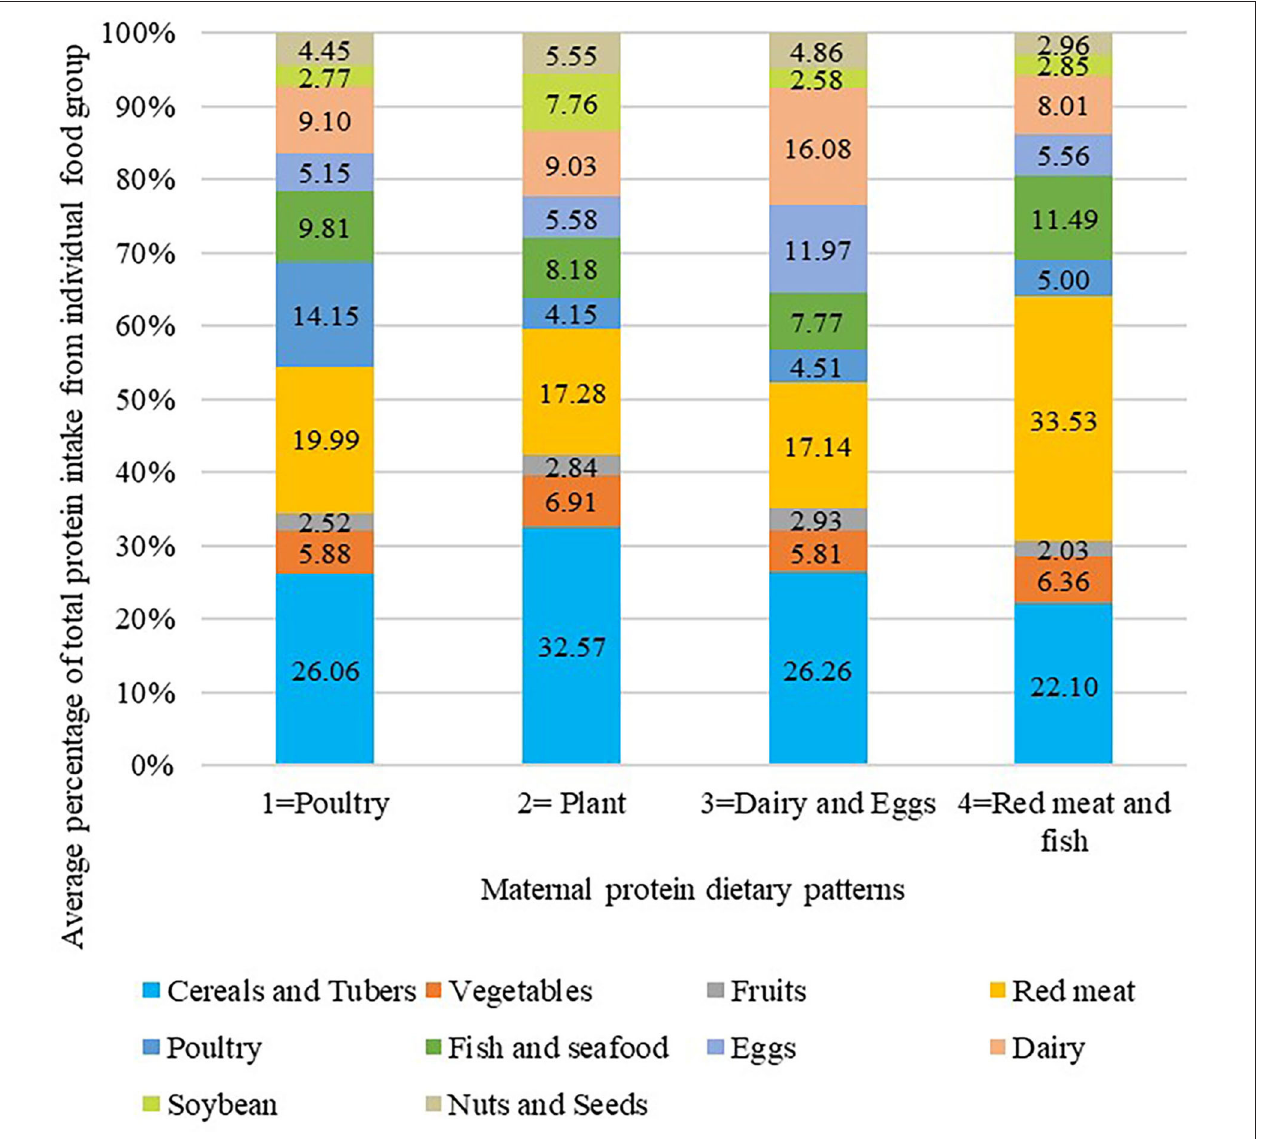
FIGURE 1 | Average percentage of total protein intake from individual food group across protein food cluster analysis. A K-means cluster analysis was used to classify participants into mutually exclusive groups. Naming of clusters was determined by the value which represent the highest consumption of one or two food groups compared with other clusters. The results of Analysis of Variance showed that there were significant differences among the percentage contribution of protein intake from each food group between four dietary pattern groups ( P <